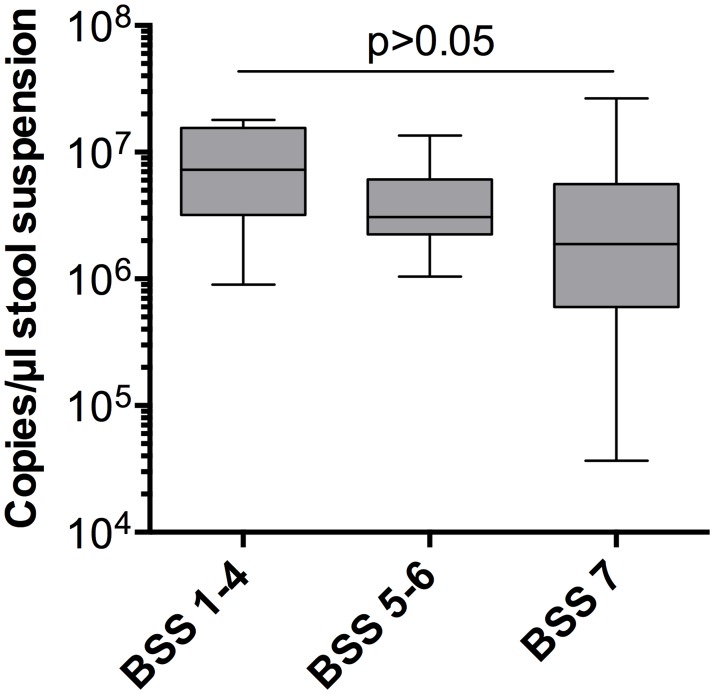
Total bacterial concentration and stool consistency.16S rDNA qPCR quantification as a measure of the total bacterial concentration was carried out in samples of three different stool consistencies, namely BSS (Bristol Stool Scale) 1–4 (constipated/normal), 5–6 (unformed/liquid), and 7 (diarrhea). 16S rDNA abundance was not statistically different between the groups (box-and-whiskers plot, median-IQR, one-way ANOVA: p = 0.1194).